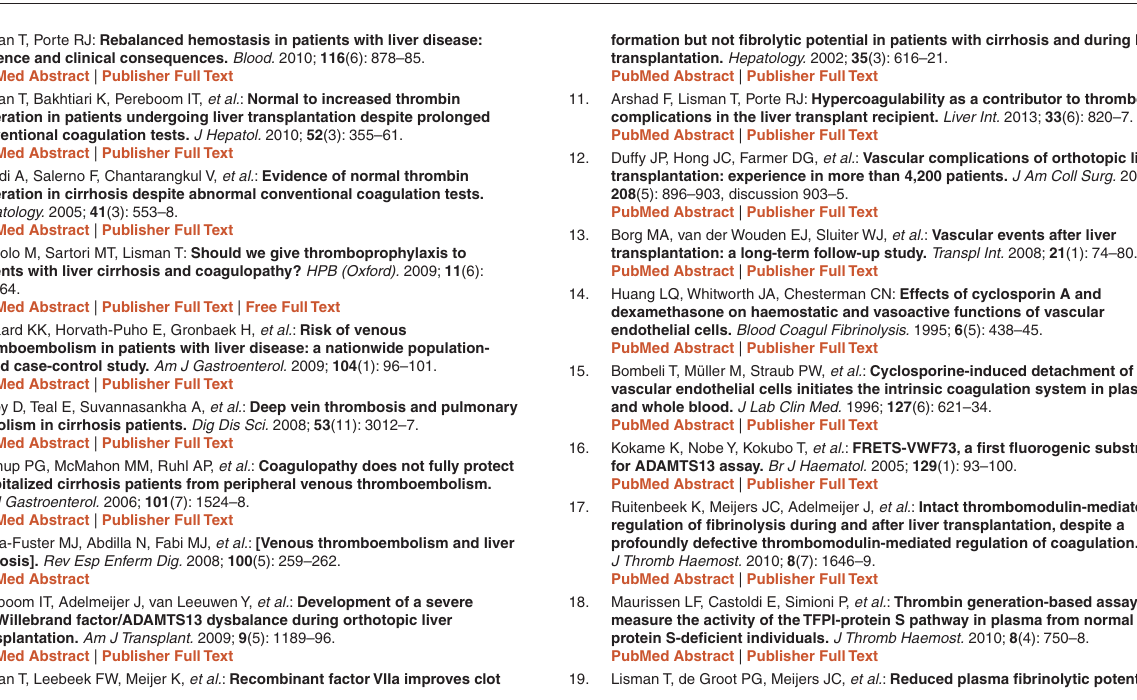
figshare : Database containing demographic data of each patient and laboratory data of each patient and control. Doi: 10.6084/ m9.figshare.1002065